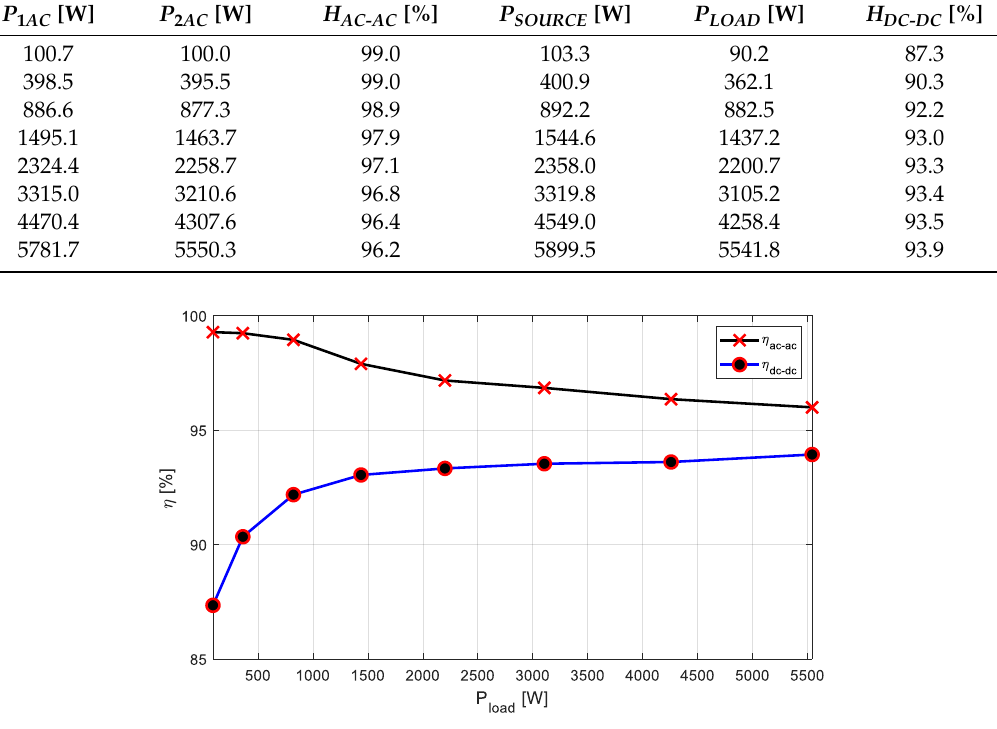
Figure 16. Leakage magnetic field (RMS values) at 20 cm and 4.5 kW .